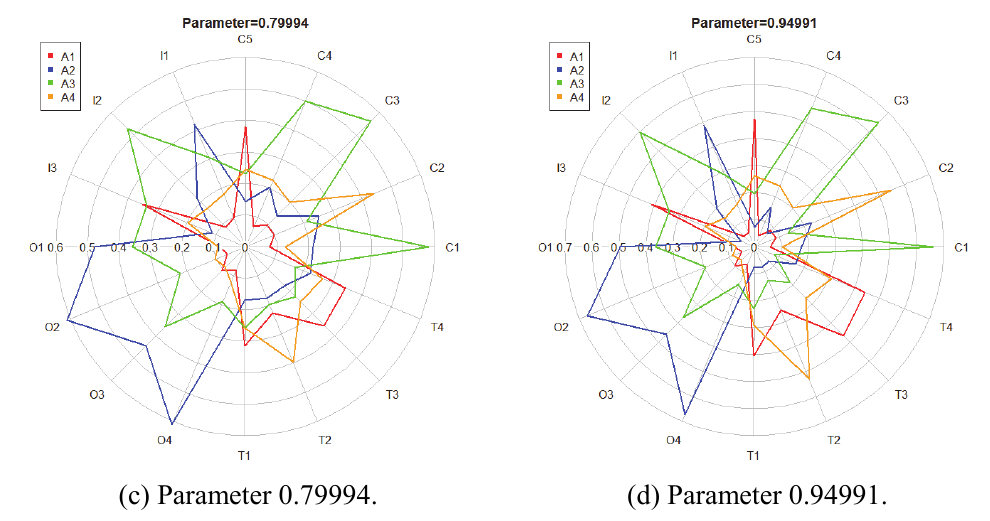
Fig. 9. Sensitivity analysis for the ANP port